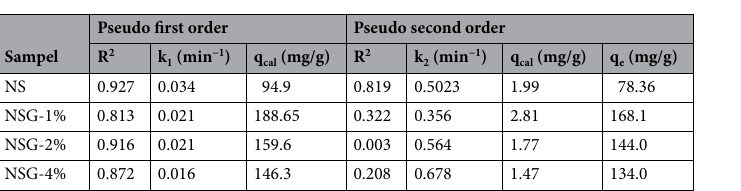
Table 3. Kinetic analysis of MB adsorption using samples.